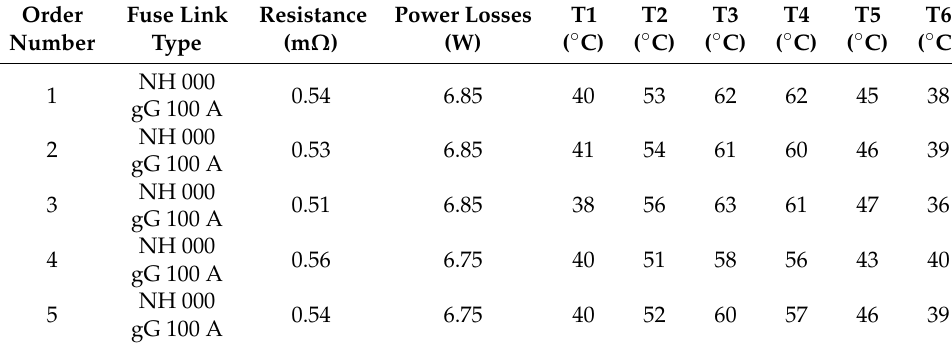
Table 3. Results obtained by Team B for fuse link type NH000 gG 100